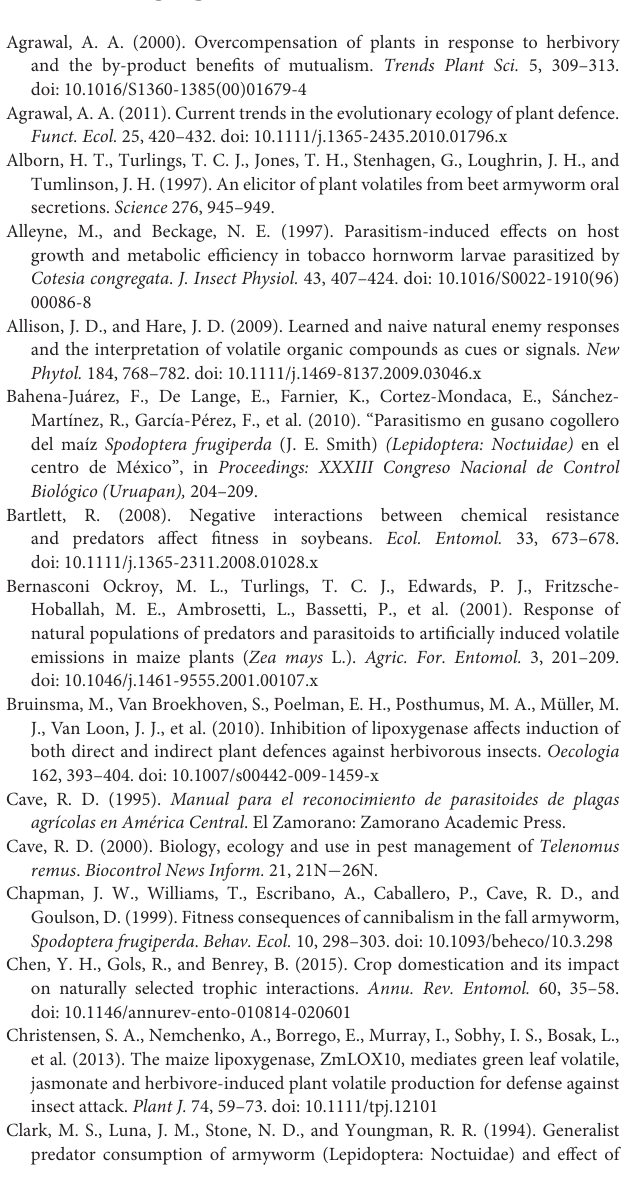
(13) indole; (14) ( E )- β -caryophyllene; (15) ( E )- α -bergamotene; (16) β -cedrene ∗ ; (17) ( E )- β -farnesene; (18) β -sesquiphellandrene ∗ ; (19) caryophyllene-oxide ∗ ; (20) methyl salicylate. ∗ = tentative identification. Figure S10 | Correlation between herbivore-inflicted damage and total volatile emission. Parameters were measured in tents that were infested with Spodoptera frugiperda larvae in the absence of parasitoid wasps (SF), for all three teosinte varieties, in all three replicates of the experiments. R 2 = 0.47, P = 0.019. The dashed line represents a linear trendline. HIPV, herbivore-induced plant volatiles. Table S1 | Survey of eight teosinte populations in Mexico in 2009. Table S2 | Absolute amounts of volatiles collected from herbivore-damaged teosinte plants (in peak area ± SE). File S1 | Survey of teosinte, herbivores, and